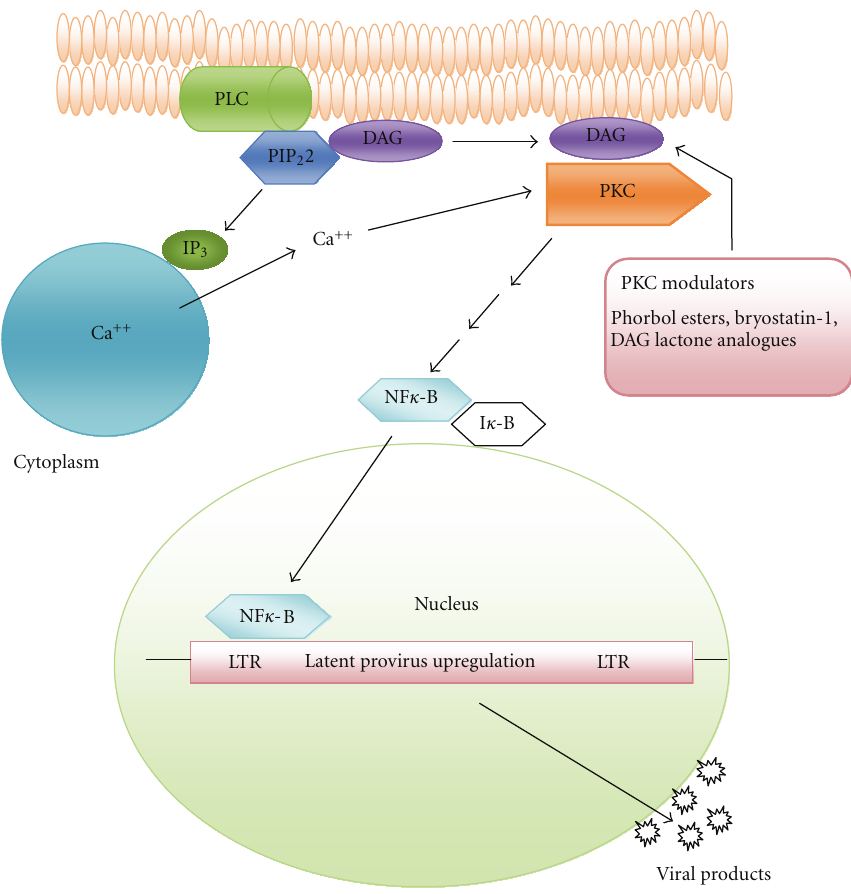
Figure 1: Overview of the mechanistic steps involved in PKC modulation toward the upregulation of latent HIV-1. PKC modulating agents represent functional analogues of DAG that similarly activate the PKC